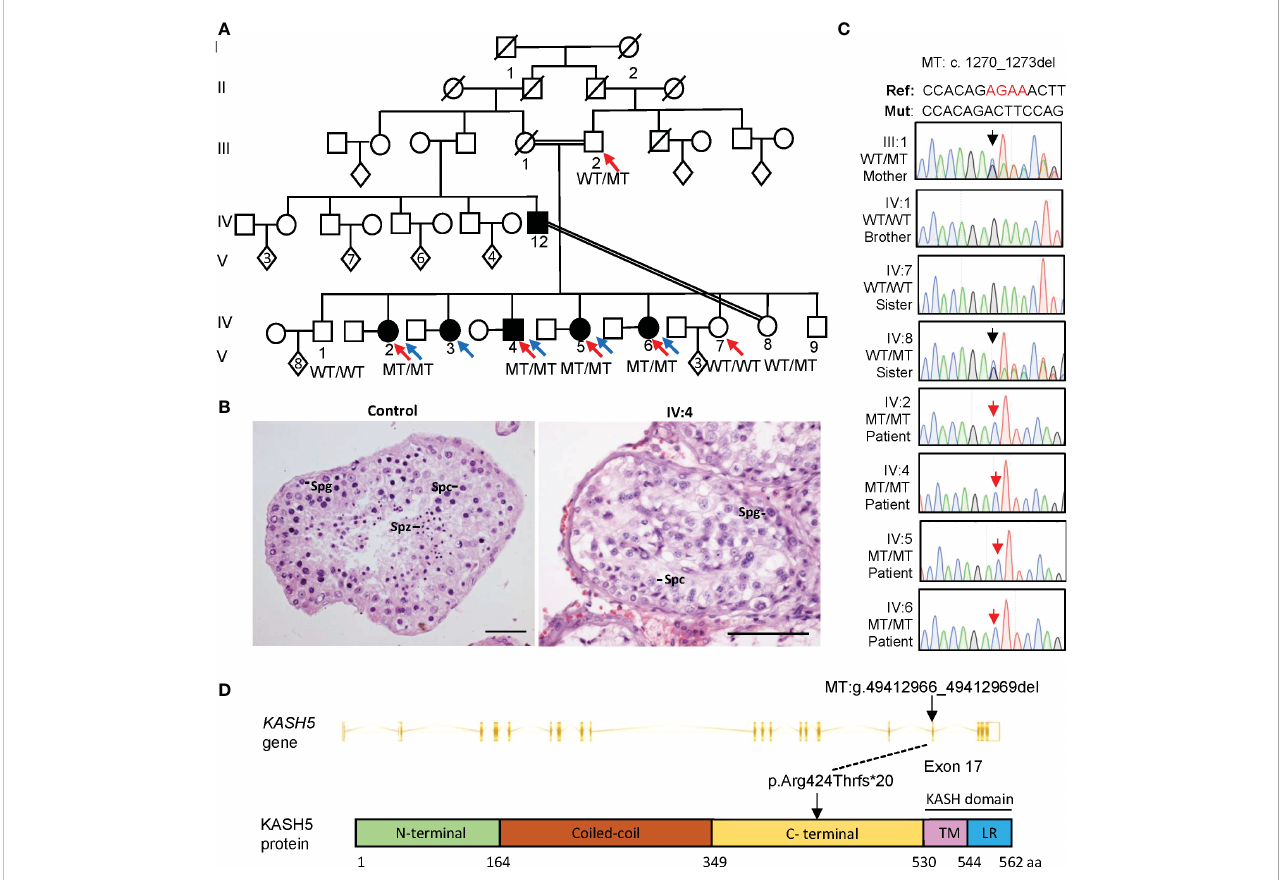
FIGURE 1 A homozygous KASH5 mutation was identi fi ed from Pakistani patients suffering from reproductive failure and born to a consanguineous marriage. (A) The pedigree of the family. Squares represent males, circles represent females, diamonds indicate offspring with the numbers inside indicating the number of children, and the slash symbols denote deceased family members. Solid squares and circles indicate affected male and female patients, respectively. Parallel slash lines indicate consanguineous marriages. Red arrows indicate members receiving whole exome sequencing. Blue arrows indicate probands. (B) Representative images of H&E-stained testicular sections from a control man diagnosed with obstructive azoospermia and patient IV:4. Spg, spermatogonia; Spc, spermatocyte; Spz, spermatozoon. Scale bars denote 50 m m. (C) Sequencing chromatograms of peripheral blood gDNA from the patients and their father (III:2), brother (IV:1) and sisters (IV:7 and IV:8). The red arrow indicates the KASH5 mutation (c.1270_1273del). (D) The gene structure and protein domains of KASH5 (Ensembl transcript ID: ENST00000447857.8). Vertical bars indicate exons and slashed lines represent introns. The non-mutant KASH5 protein (562 amino acids) comprises fi ve domains: N-terminal domain, coiled-coil domain, the C-terminal domain, transmembrane (TM) domain, and the leucine-rich (LR) domain. The mutation (g.49412966_49412969del) locates in exon 17, which causes a frameshift within the C-terminal domain. Lines indicate the mutation positions at the genomic and protein levels